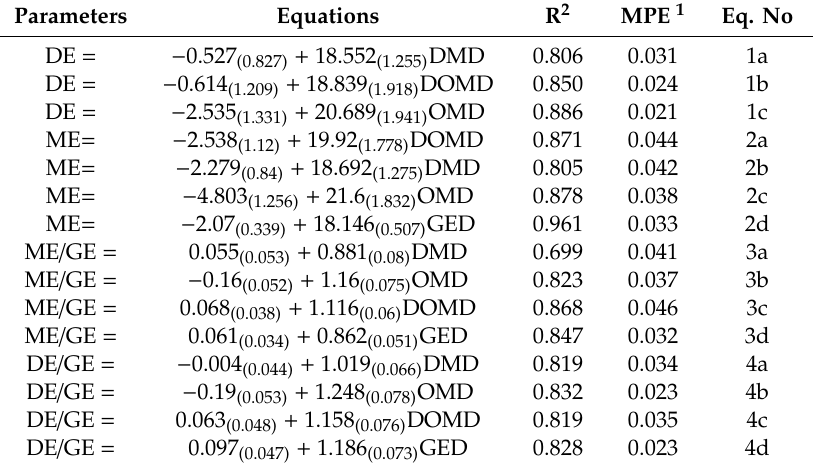
Table 2. Linear prediction equations for herbage energy concentrations (MJ / kg DM) and ratios using nutrient digestibility